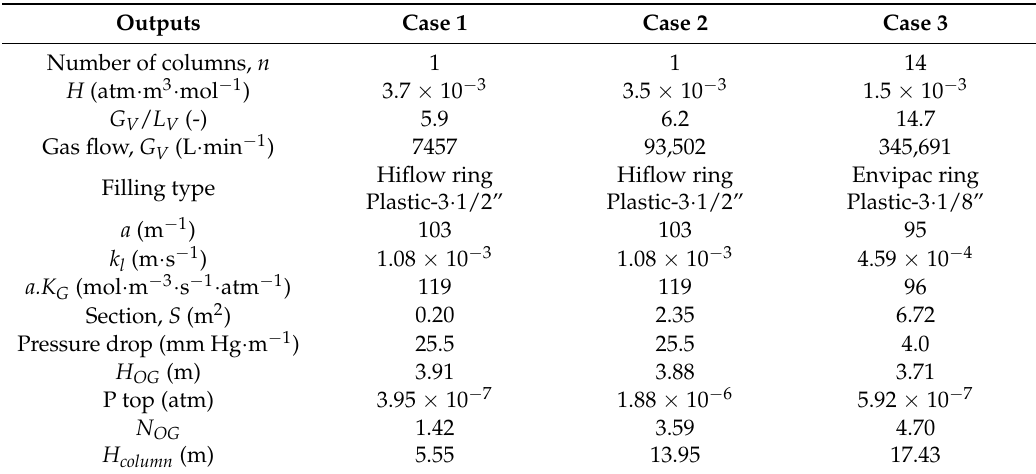
Table 4. Parameters for stripping columns from case study simulations.